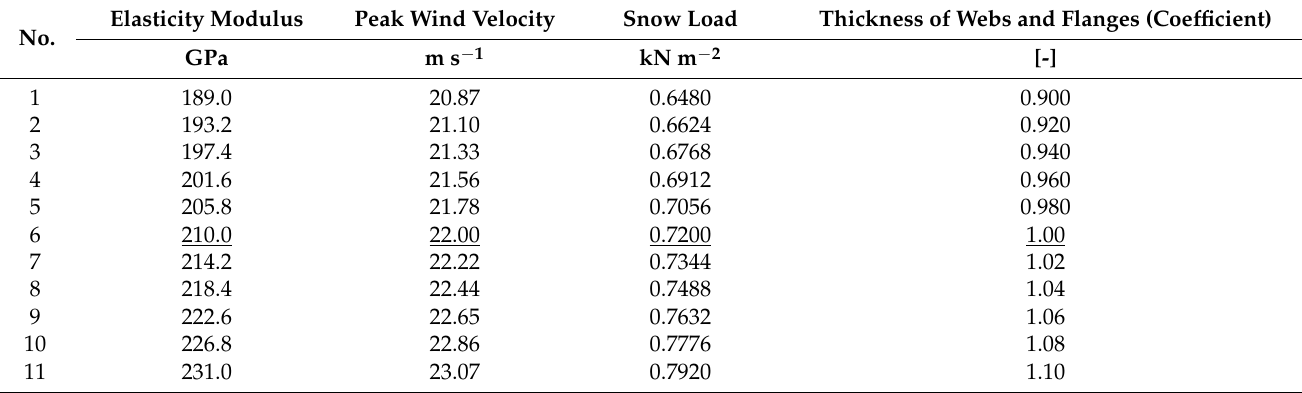
Table 2. Discretization of the given uncertainty sources for the response function